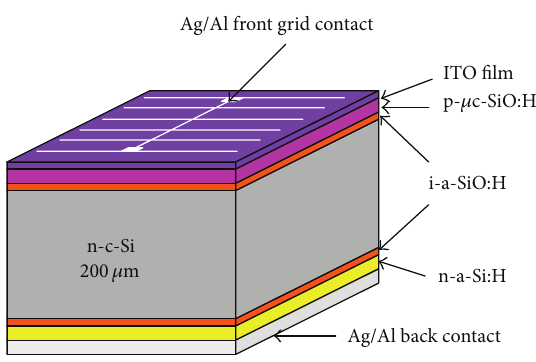
Figure 1: Schematic diagram of c-Si-HJ solar cells.